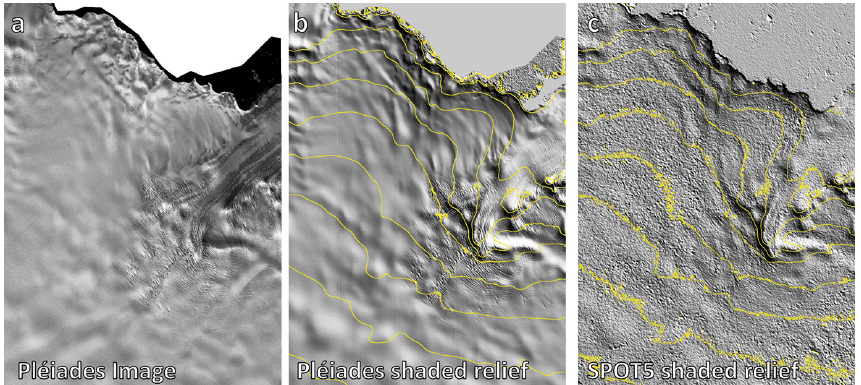
Figure 5. Comparison of the 14 December 2007 SPOT 5 and 6 February 2013 Pléiades DEMs of Astrolabe Glacier. (a) shows the Pléiades image. The two right panels show shaded relief images derived from the Pléiades DEM (b) and the SPOT 5-HRS DEM (c) with the 100m elevation contour lines